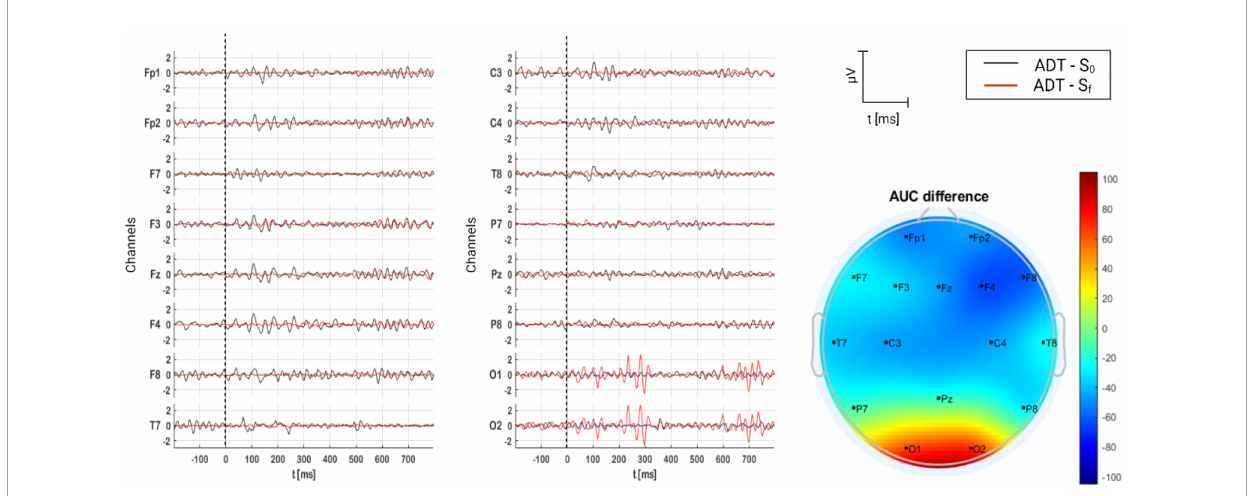
FIGURE11 Grand average of AERPs at S 0 (initial session) and S f (final session) for ADT group. In addition, the AUC difference of these two grand averages (S f – S 0 ) is topographically plotted in µ V.